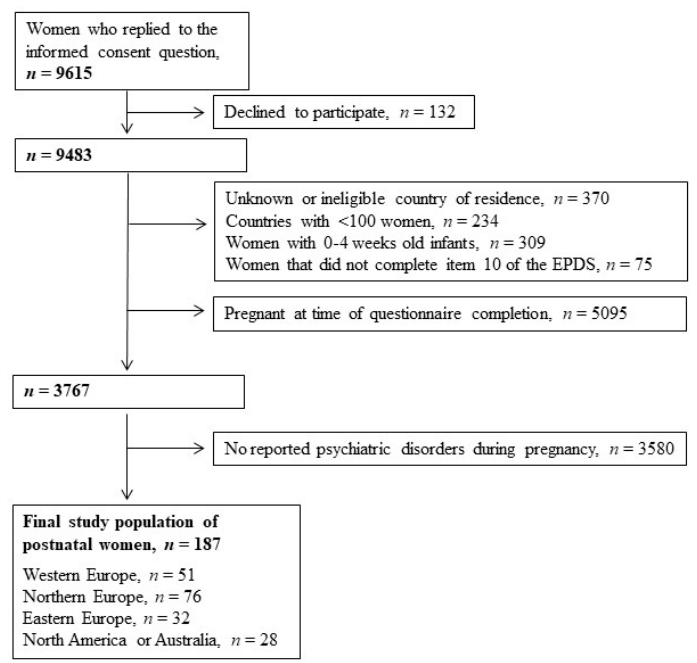
Figure 1. Data flow to achieve the final study population. Abbreviations: EPDS = Edinburgh Postnatal Depression Scale. Psychiatric disorders include depression, anxiety and other psychiatric disorders (i.e., bipolar, panic and two-sided personality disorders). Table 1. Maternal sociodemographic, lifestyle and health-related characteristics of the study population by antidepressant treatment during pregnancy. 1 Sociodemographic, Life-Style and Health Characteristics